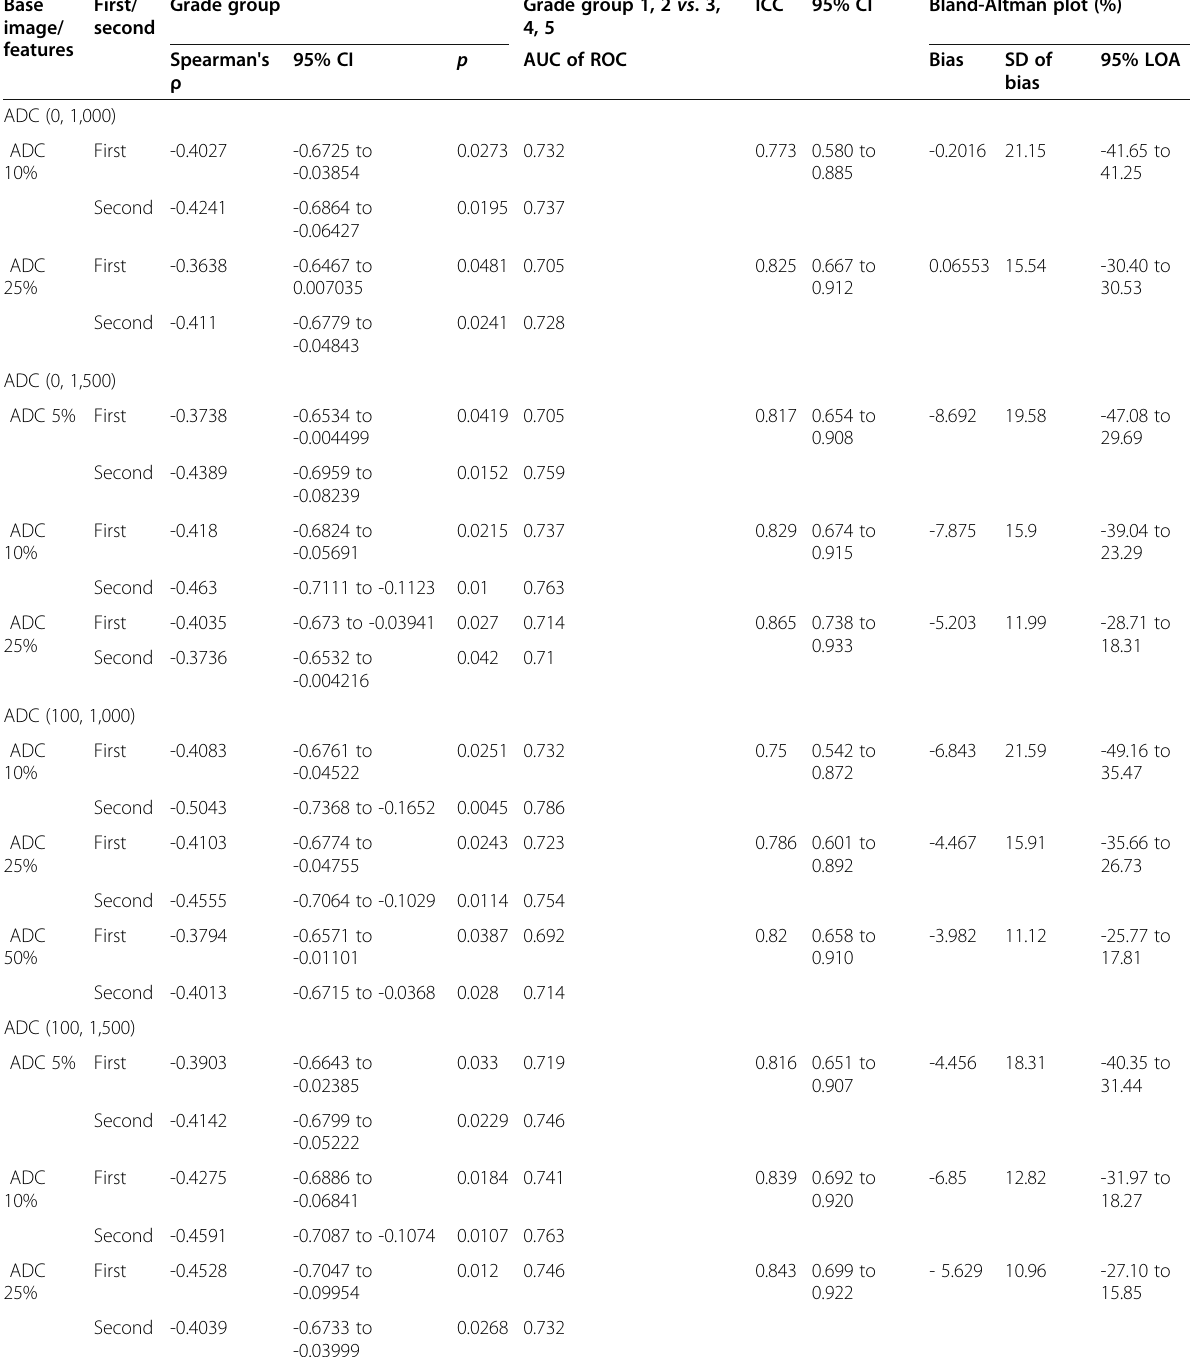
Table 3 Summary of the correlation between features and grade group as well as the repeatability in peripheral zone